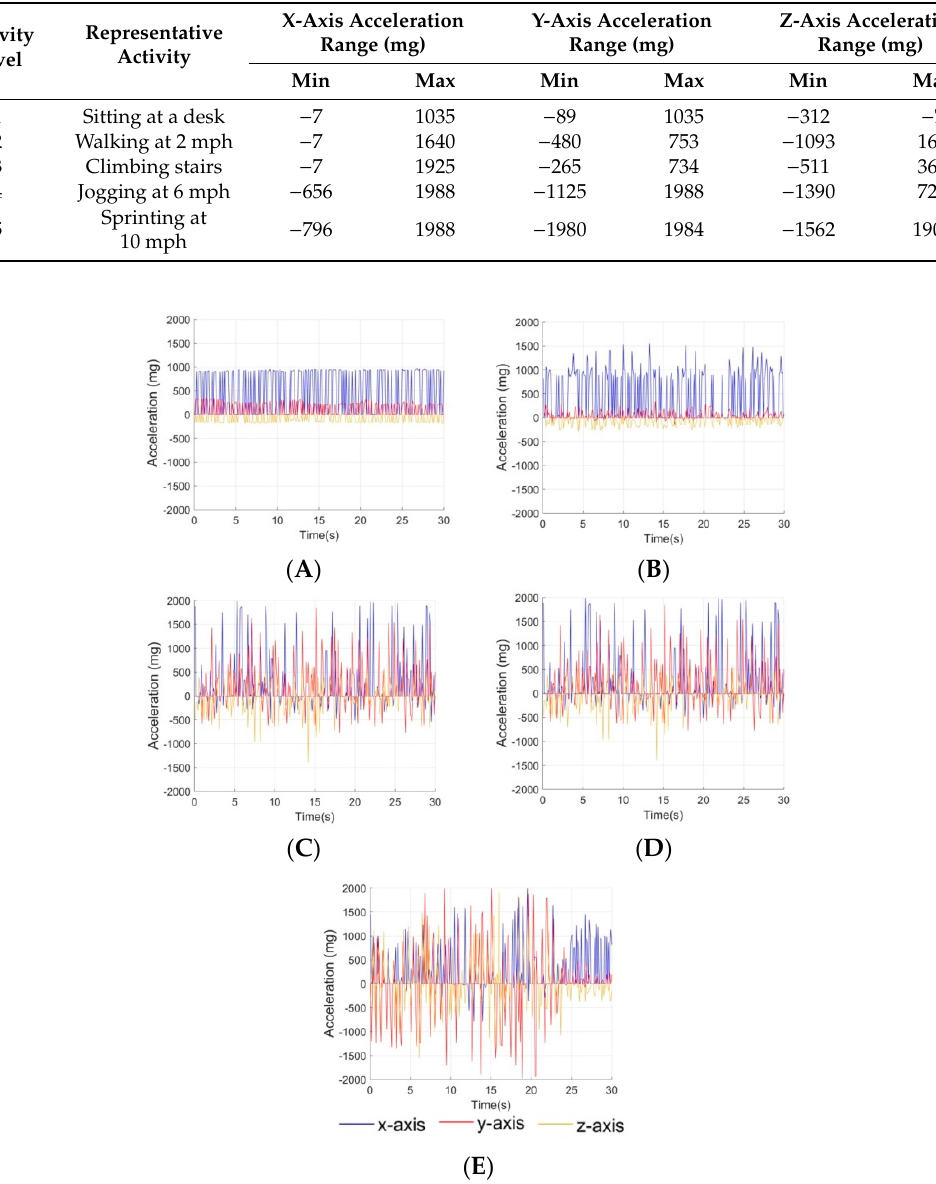
Figure 6. Representative triaxial accelerometry representing intensity levels: ( A ) level 1 sitting, ( B ) level 2 walking, ( C ) level 3 climbing stairs, ( D ) level 4 jogging, ( E ) level 5 sprinting.